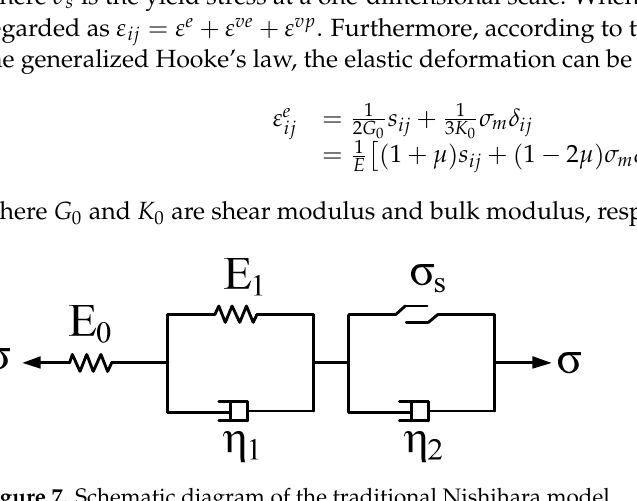
Figure 7. Schematic diagram of the traditional Nishihara model.